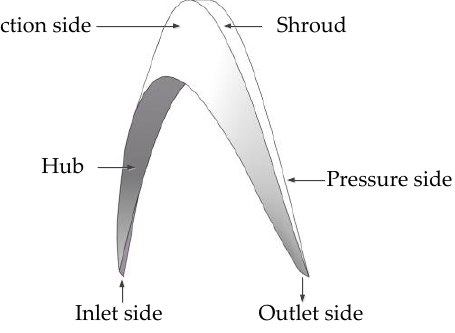
Figure 9. The frame of the helical–axial blade.